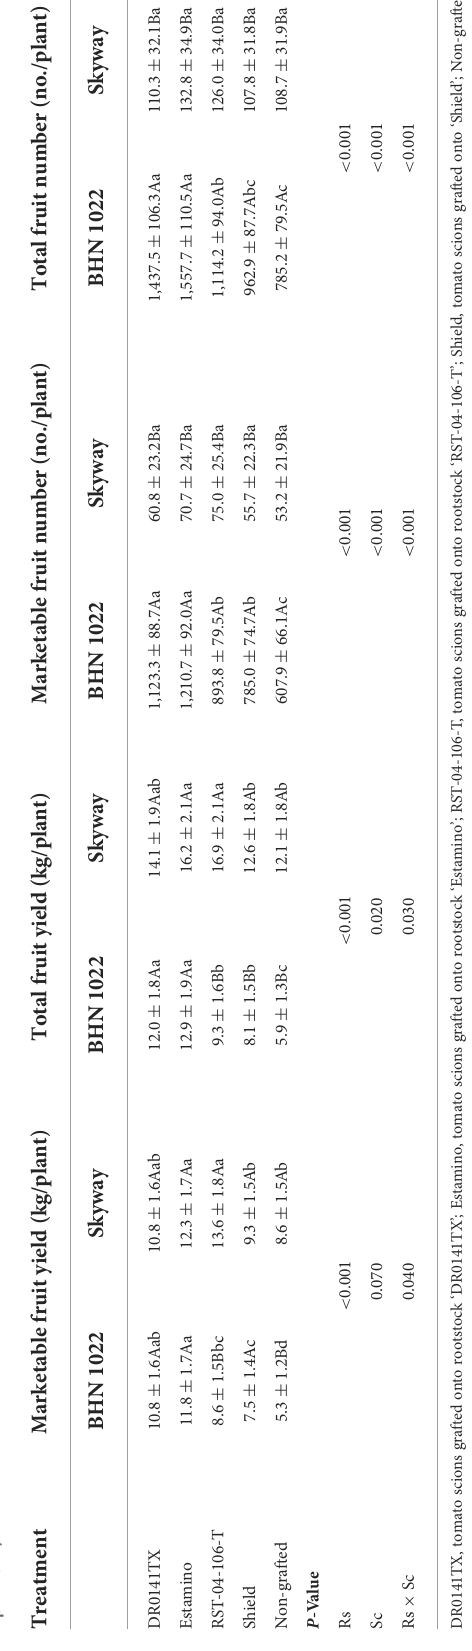
TABLE 3 Average marketable fruit weight from the grafted ‘BHN 1022’ grape tomato and ‘Skyway’ beefsteak tomato scions in the